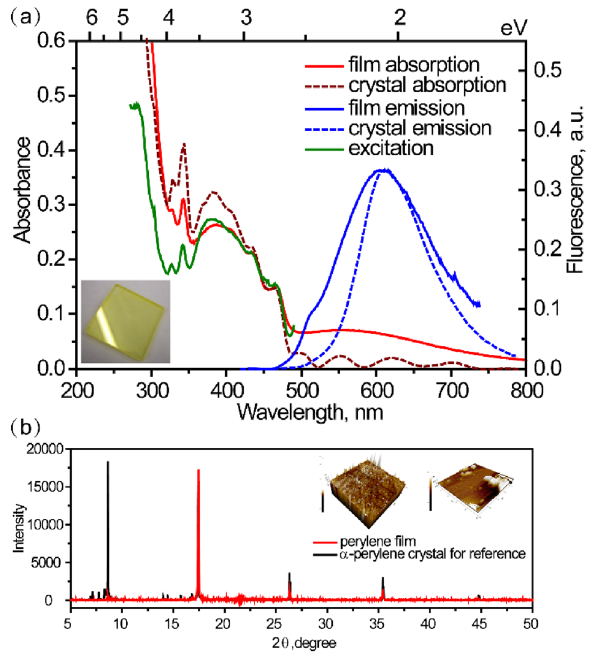
Figure 1. (a) Steady-state absorption, fluorescence and excitation spectra (solid curves) of perylene film (λ ex = 390 nm, λ em = 510 nm). Absorption and emission spectra (dotted curves) of α-perylene crystal are offered as reference (λ ex = 400 nm) 8 . (b) XRD spectrum of perylene film (red curve) and of α-perylene bulk crystal (black curve). Insets show the AFM images of perylene